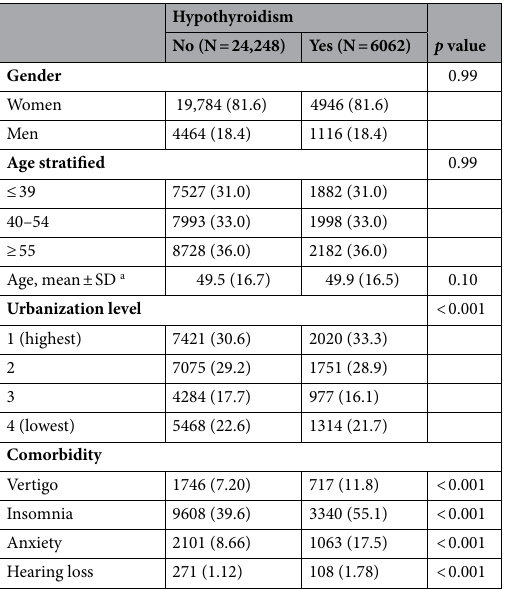
Table 1. Comparisons in demographic characteristics and comorbidities in patient with and without Hypothyroidism. Chi-Square Test, a t-test. † The urbanization level was categorized by the population density of the residential area into 4 levels, with level 1 as the most urbanized and level 4 as the least